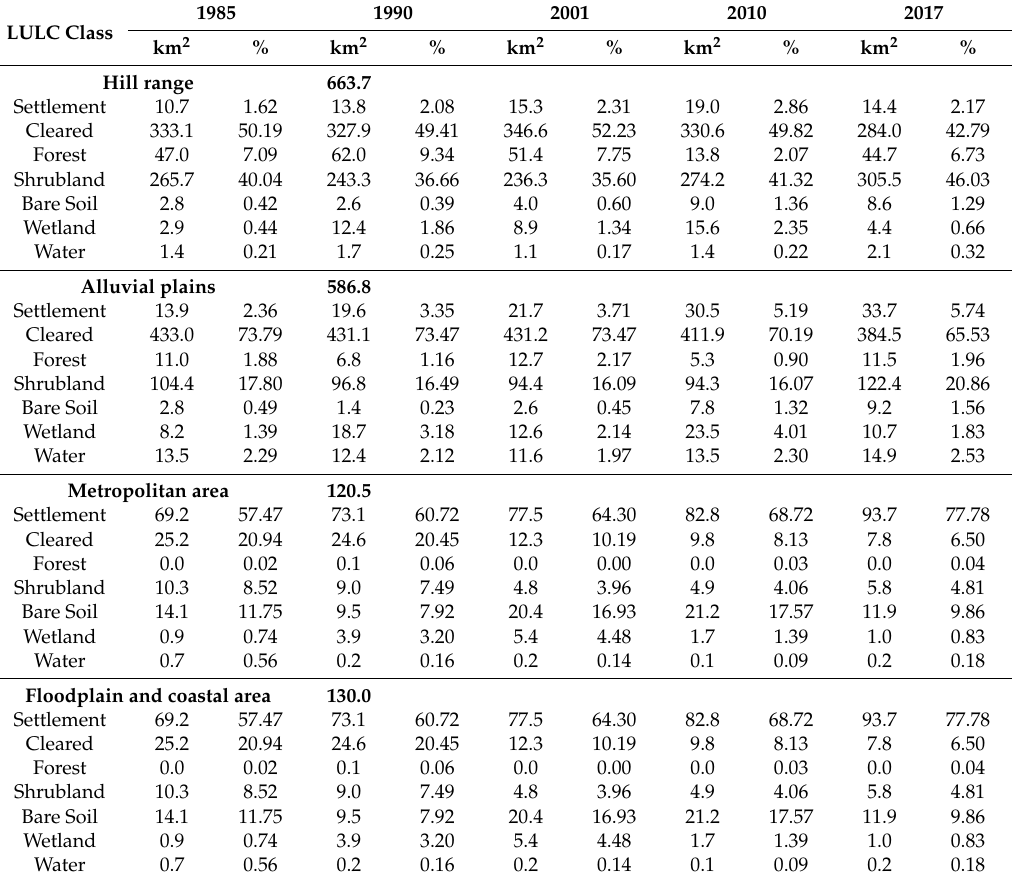
Table A1. Area size calculation of the four landscape units separated per LULC class for 1985, 1990, 2001, 2010, and 2017.